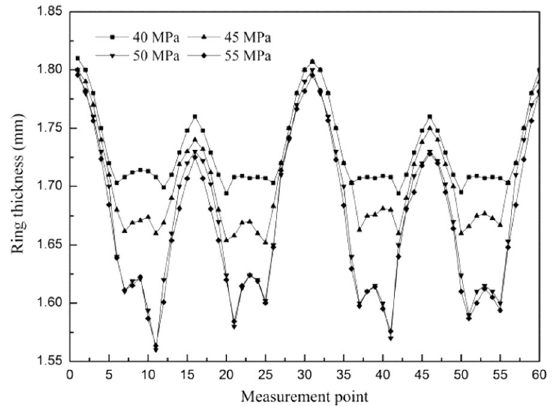
Figure 12 Distribution of the circumferential wall thickness of the intermediate section under different internal pressures